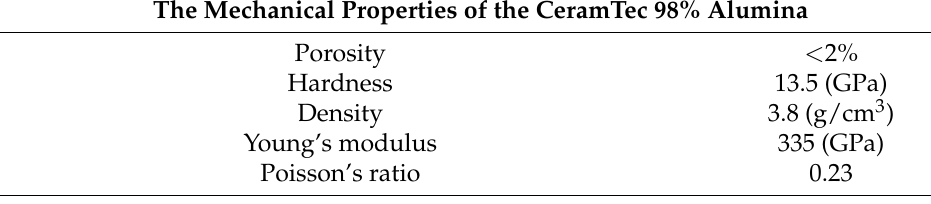
Table 1. The properties of CeramTec 98% alumina for the HFDEM